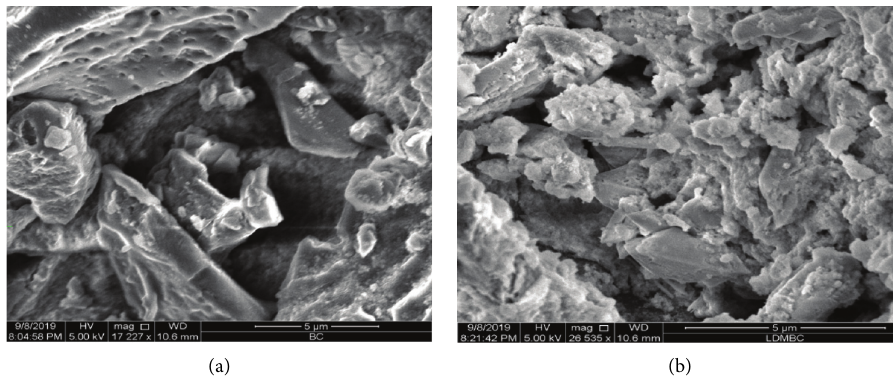
Figure 5: (a) SEM analysis of biochar and (b) lanthanum doped magnetic Teff straw